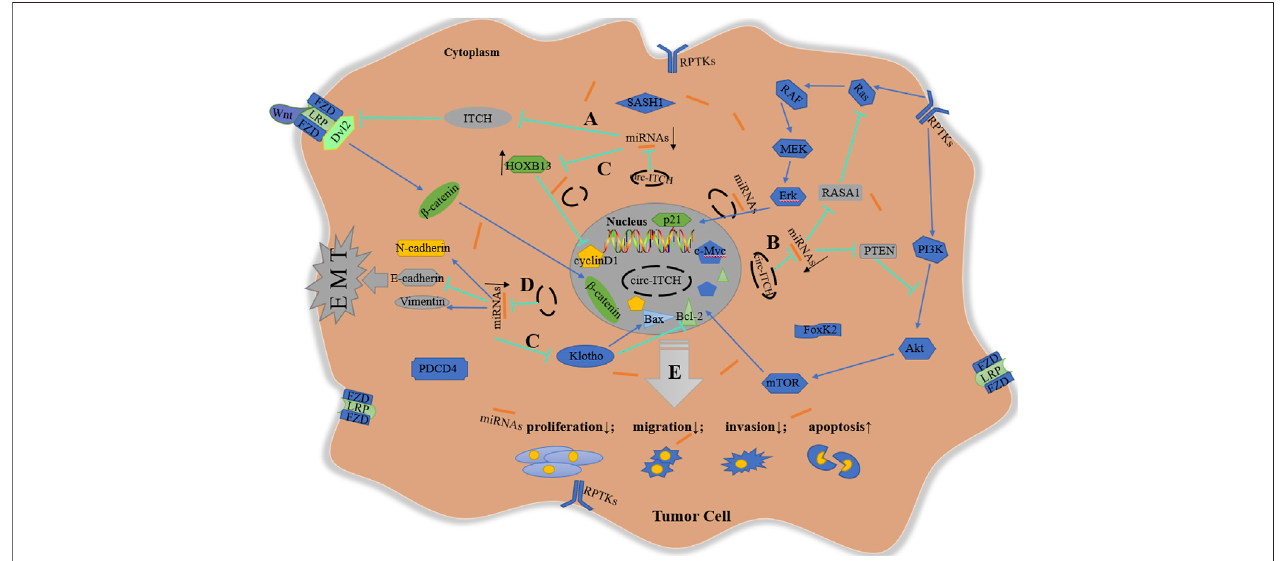
FIGURE 2 | Schematic diagram of anti-tumor mechanism of circ-ITCH. (A) via sponging miR-7, miR-17, miR-20a, miR-22-3p, and miR-214, circ-ITCH increases ITCH levels to inhibit Wnt signaling pathway in ESCC, CRC, LC, TNBC, PCa, HCC and GC; (B) via sponging miR-7, miR-14, miR-22, miR-145 and miR-224, circ-ITCH activate the inhibitory proteins (RASA1 and PTEN) of Erk and PI3K cascade to suppress the activation of these signaling pathway in BCa, OS, NPC and OC; (C) via sponging miR-17-5p, miR-421, miR-524, miR-660, miR-106a-5p, miR-224-5p, miR-93-5p and miR-199a-5p, circ-ITCH regulates cell cycle-related proteins to inhibitcellproliferationandpromotecellapoptosisinPCa,OS,OSCC,HCC,ccRCC,CC,glioma,melanomaandGC; (D) Via spongingmiR-184andmiR-199a-5p,circ- ITCH suppressesEMTprocess inHCCand GC; (E) Inaddition,circ-ITCHcandirectlyregulatesomeproteins withoutspeci fi ctargetmiRNAs.Inaword,circ-ITCHplays an anti-tumor role by negatively regulating cell proliferation, invasion, migration, and positively regulating cell apoptosis.